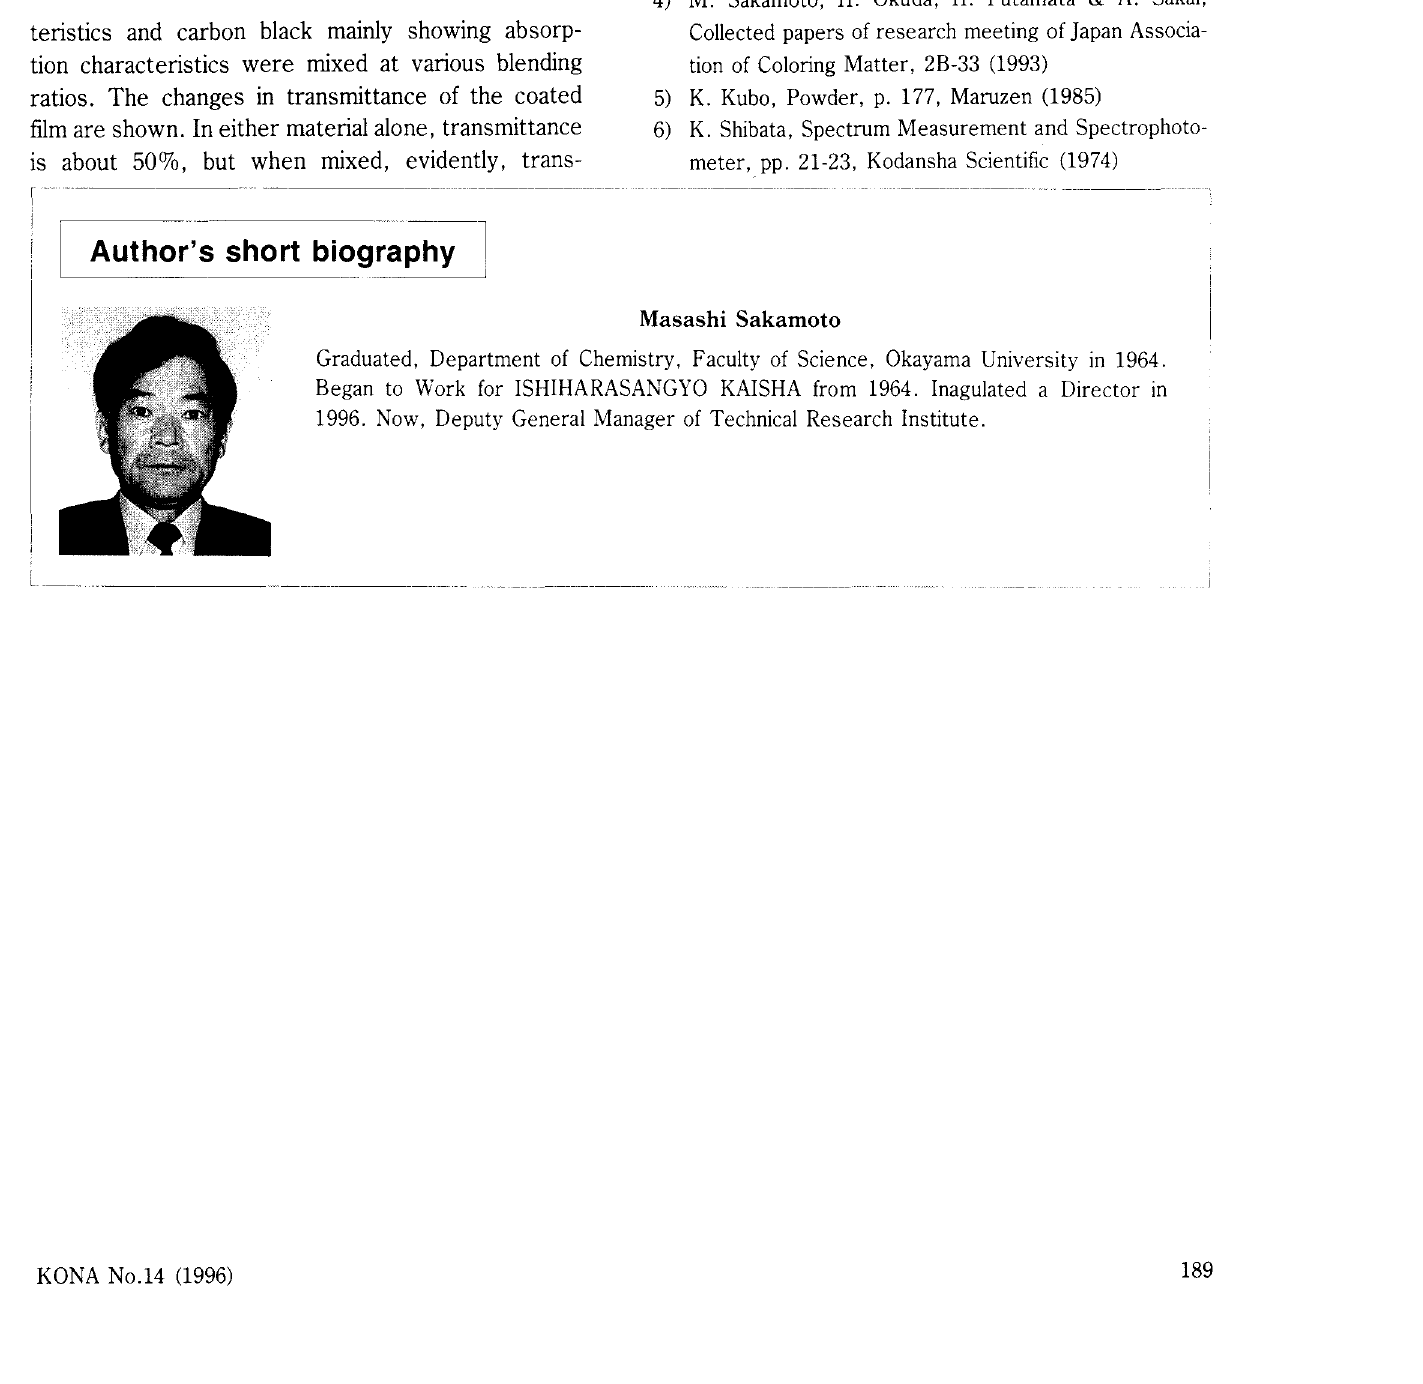
Fig. 13 Effect of mixing with CR-50 and carbon black on reflectance at 550